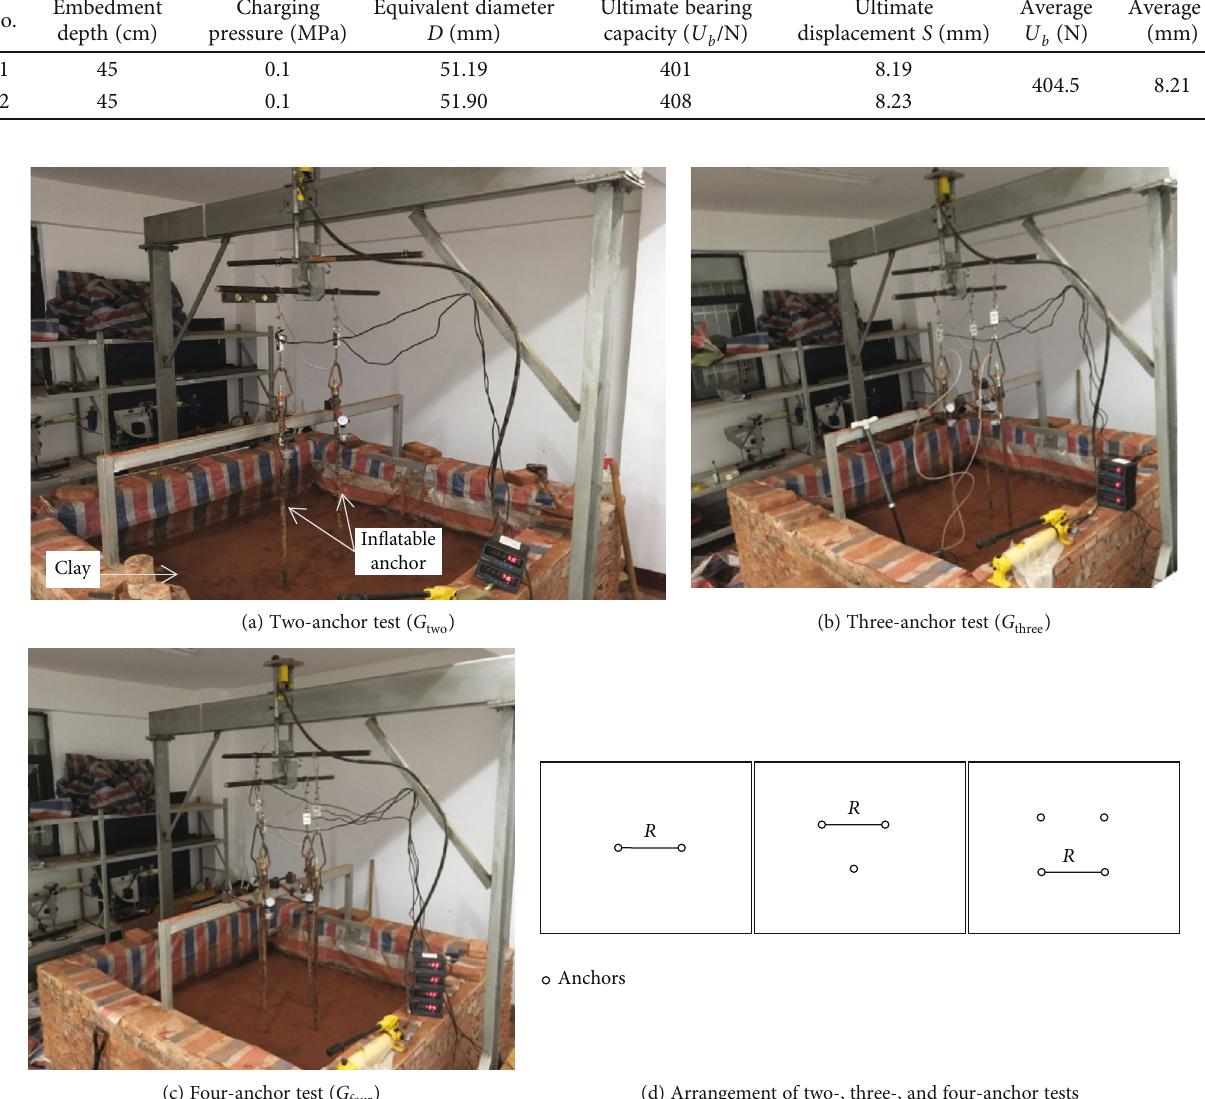
Figure 6: Schematic of the plane arrangement of two-, three-, and four-anchor